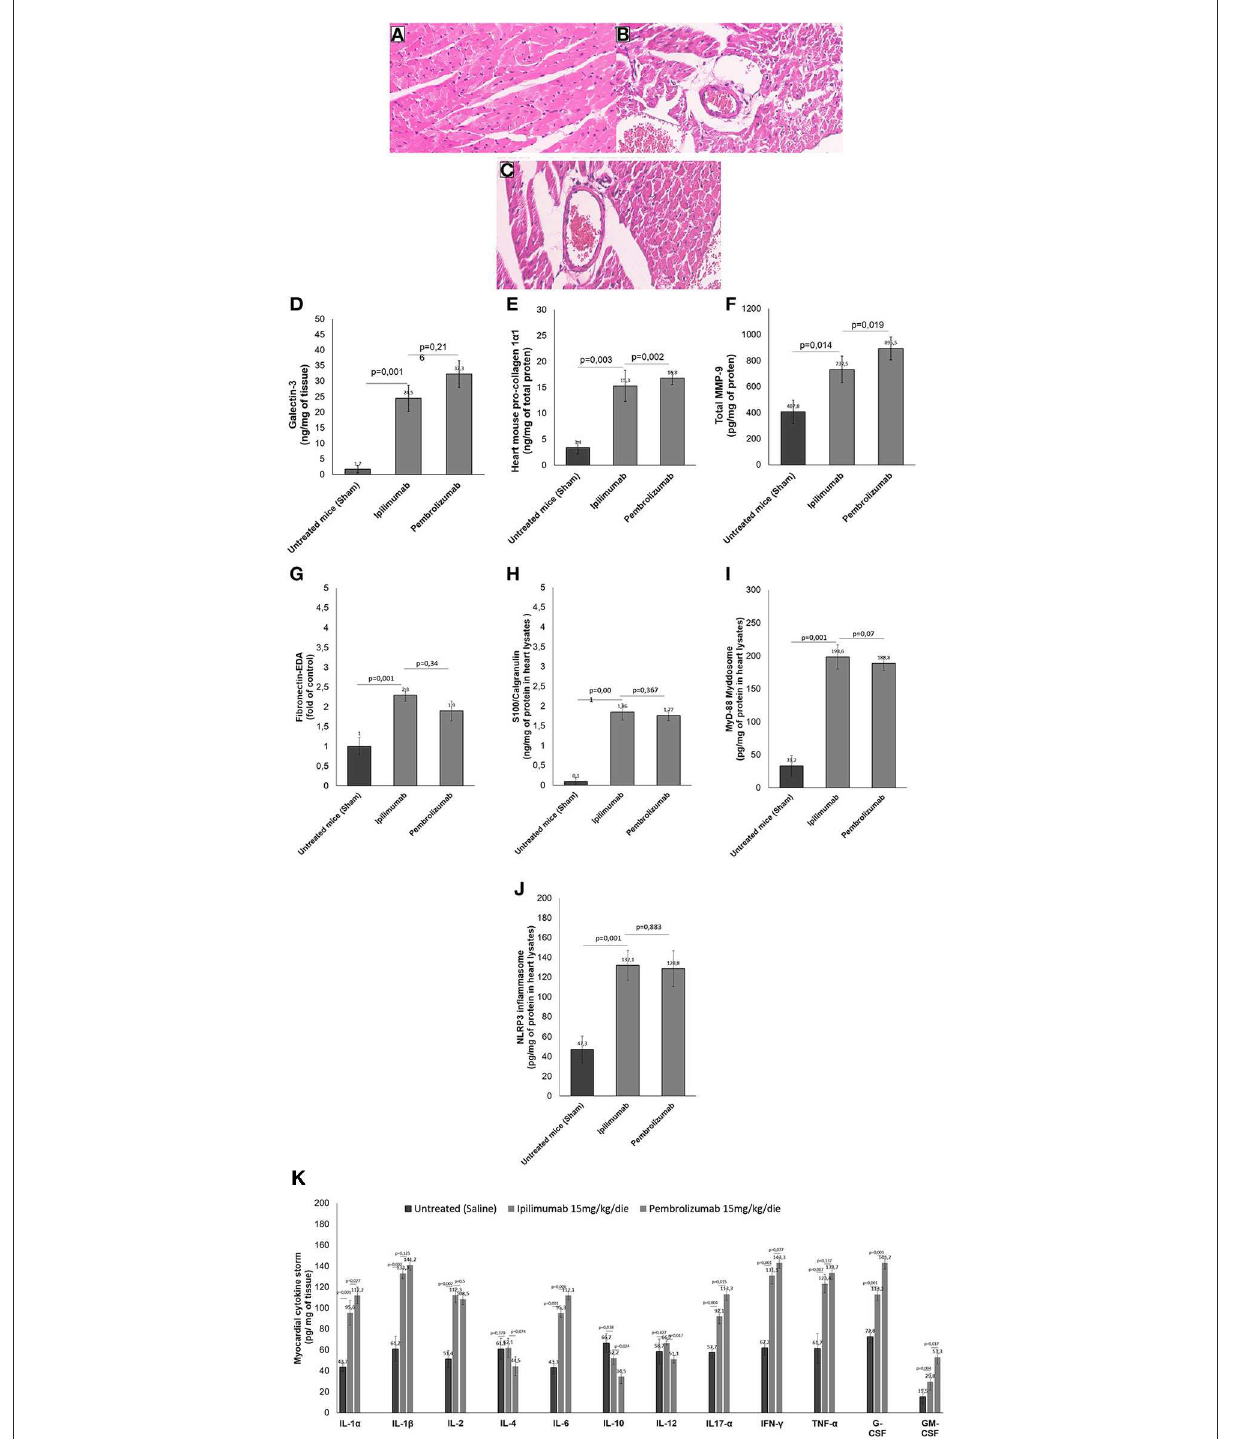
FIGURE6 Histological analysis of the hearts of mice untreated or treated with ICIs. (A) Hematoxylin-eosin staining of longitudinal sections in control untreated mice (x40); (B) hematoxylin-eosin staining of longitudinal sections in mice treated with Ipilimumab ( × 40); (C) hematoxylin-eosin staining of longitudinal sections with fibrosis in mice treated with Pembrolizumab ( × 40). (D) Cardiac expression of galectin-3 (ng/mg of tissue), (E) mouse pro-collagen 1- α (ng/mg of total proten), (F) MMP-9 (pg/mg of protein), (G) Fibronectin EDA (fold of control), (H) S100 Calgranulin (ng/mg of protein in myocardial tissue lysate), (I) MyD-88 (pg/mg of protein in myocardial tissue lysate) and (J) NLRP-3 (pg/mg of protein in myocardial tissue lysate) after short-term treatment with ICIs. In (K) , Twelve cytokines (IL-1 α , IL-1 β , IL-2, IL-4, IL-6, IL-10, IL-12, IL17- α , IFN- γ , TNF- α , G-CSF, GM-CSF) were analyzed in heart lysates and reported as pg of cytokine normalized for mg of tissue. Error bars depict means ± SD ( n =